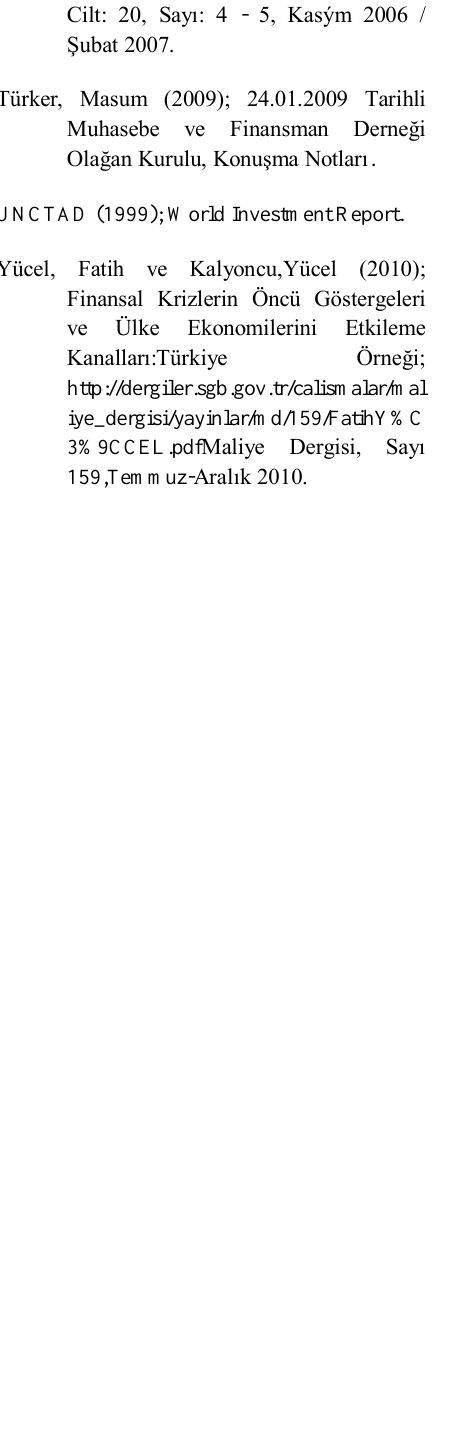
The Relationship Between Accounting Practices and Effects of Financial Crisis in Turkey: A Case Study on an Oil